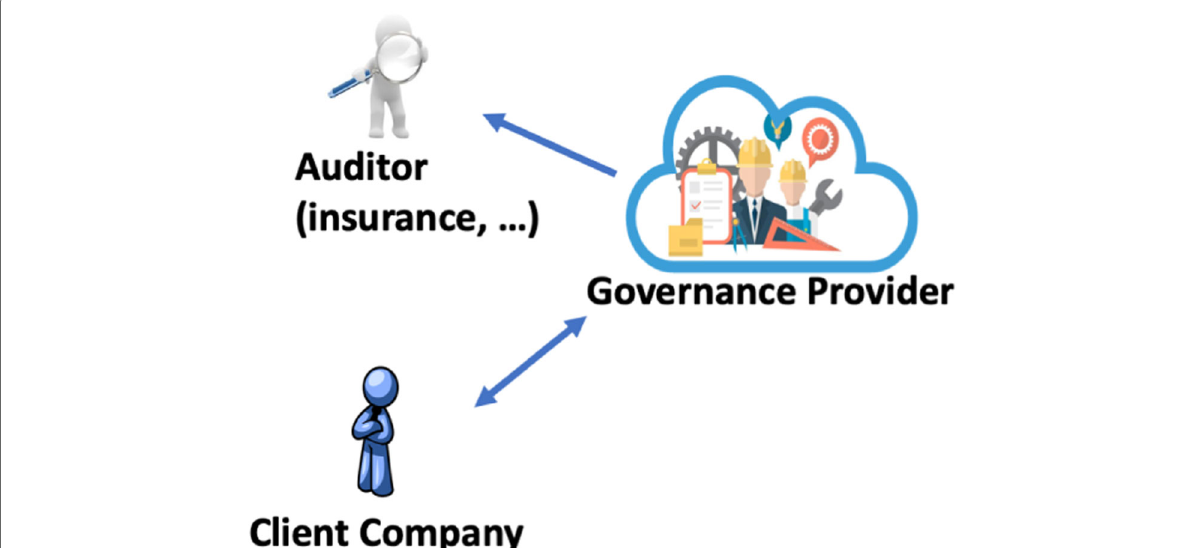
Fig. 1 Actors of the governance model. The arrows denote data flows. The governance provider offers a trusted environment in which it tracks risk for the client company and furnishes proof of implementation of risk-mitigating actions to